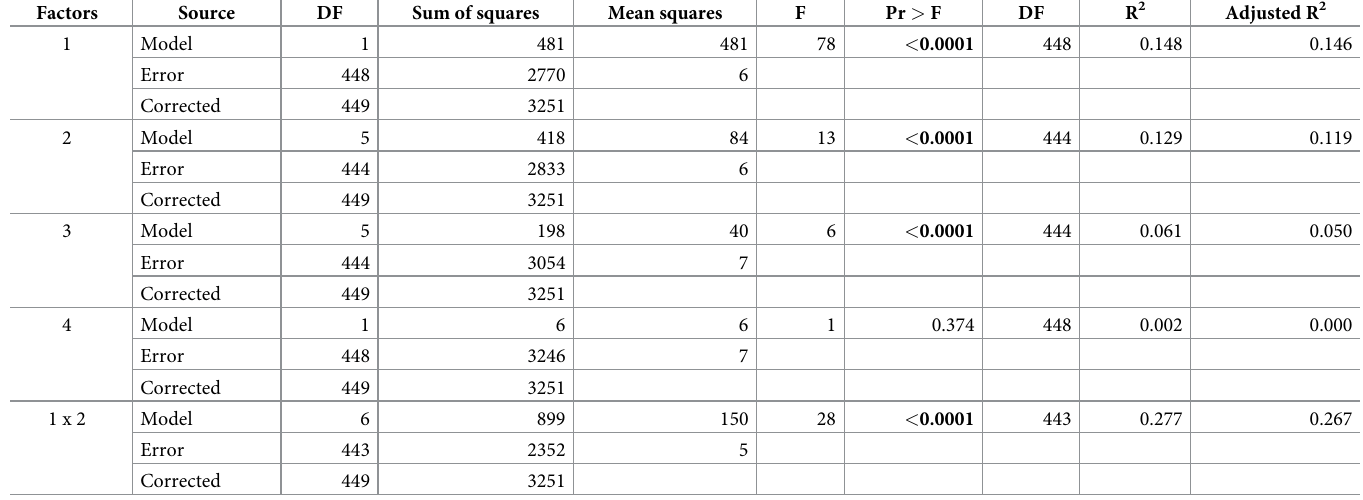
Table 6. ANOVA table for the dimensionless parameter MT%CL of the dorsal fin and tail fluke cross-sections with the independent factors fin type (Factor 1), sec- tion # (Factor 2), species (Factor 3) and body length (Factor 4).